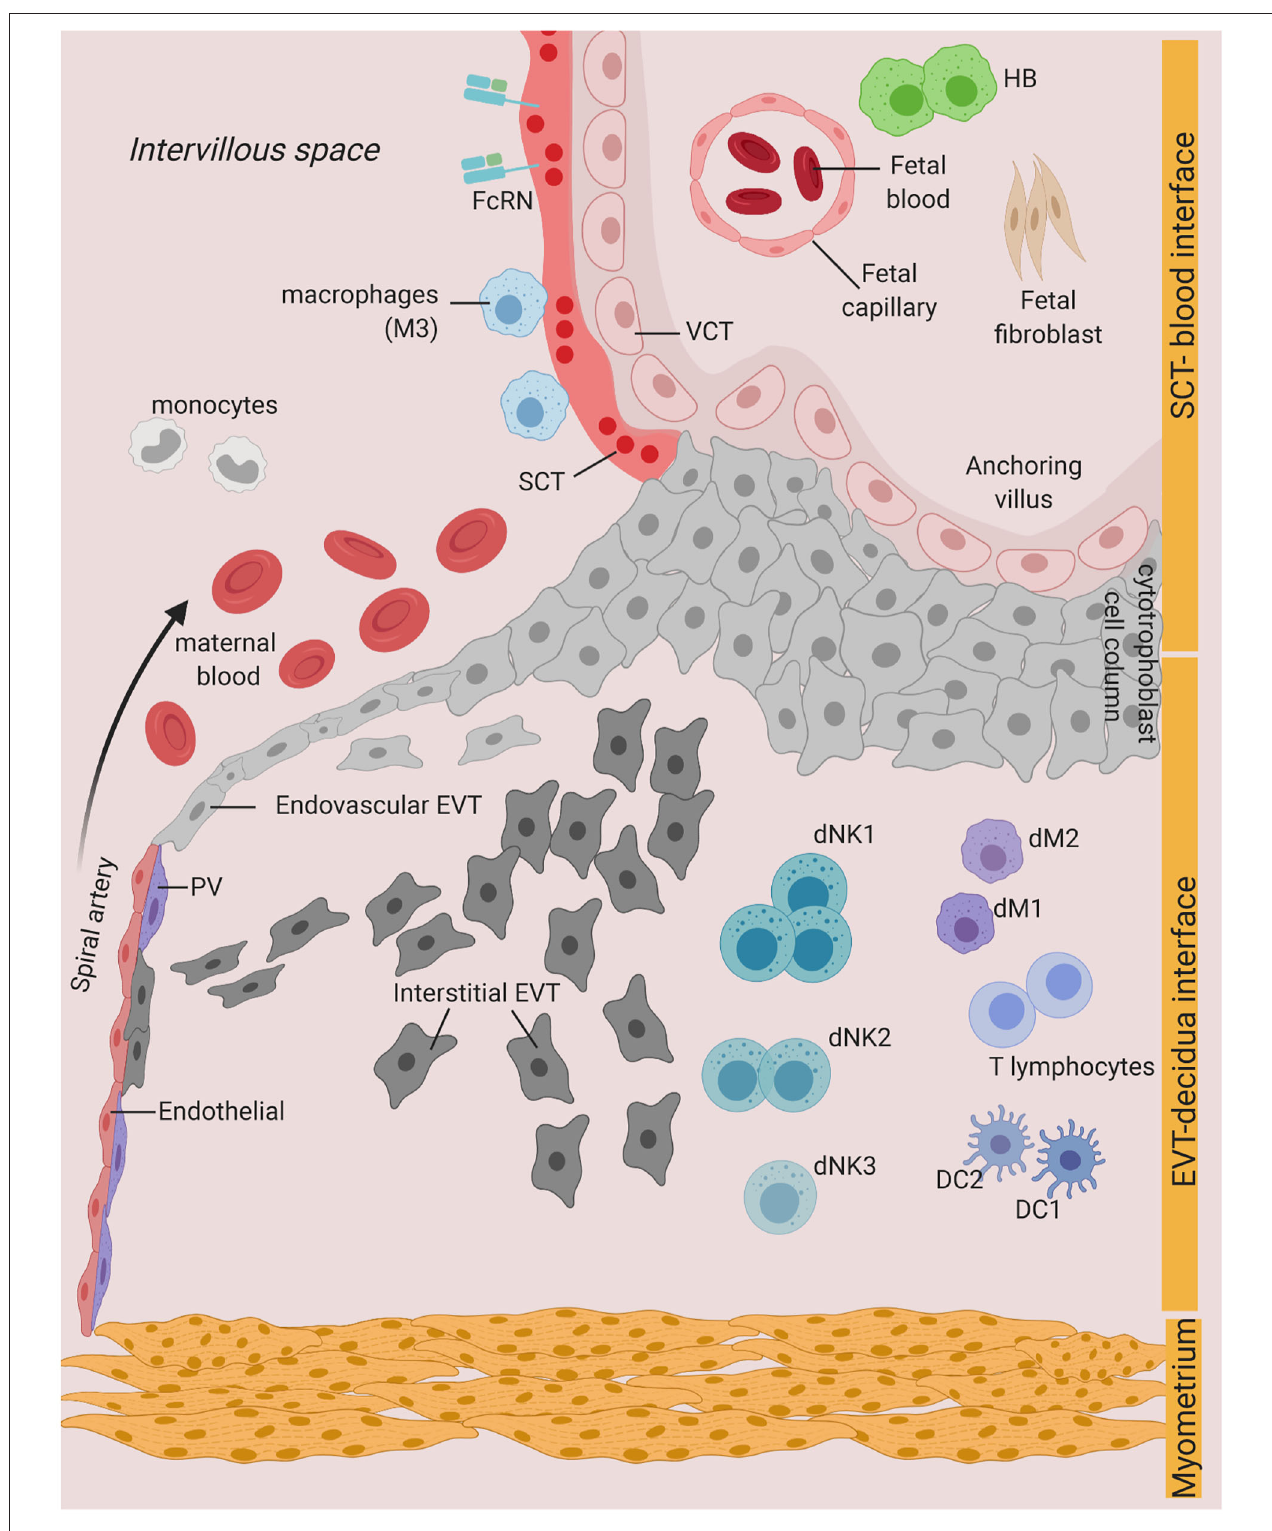
FIGURE 1 | Possible infection and vertical transmission route at the maternal-fetal interface. Illustration representing the anchoring placenta villi of early pregnancy, with onset of maternal blood circulation bathing the intervillous space. SCT-blood interface represents the SCT barrier exposed to maternal blood and immune cells. EVT-decidua interface represents the interface between EVT and maternal decidua cells. Major cell types of placenta trophoblast and decidua from Vento-Tormo et al. (10) are represented. SCT, syncytiotrophoblast; VCT, villous cytotrophoblast; EVT, extravillous trophoblast; DC, dendritic cell; dNK, decidua Natural killer cells; dM, decidua macrophages; HB, Hofbauer cell; PV, perivascular cells; FcRN, neonatal Fc receptor. Figure is created by BioRender.com.